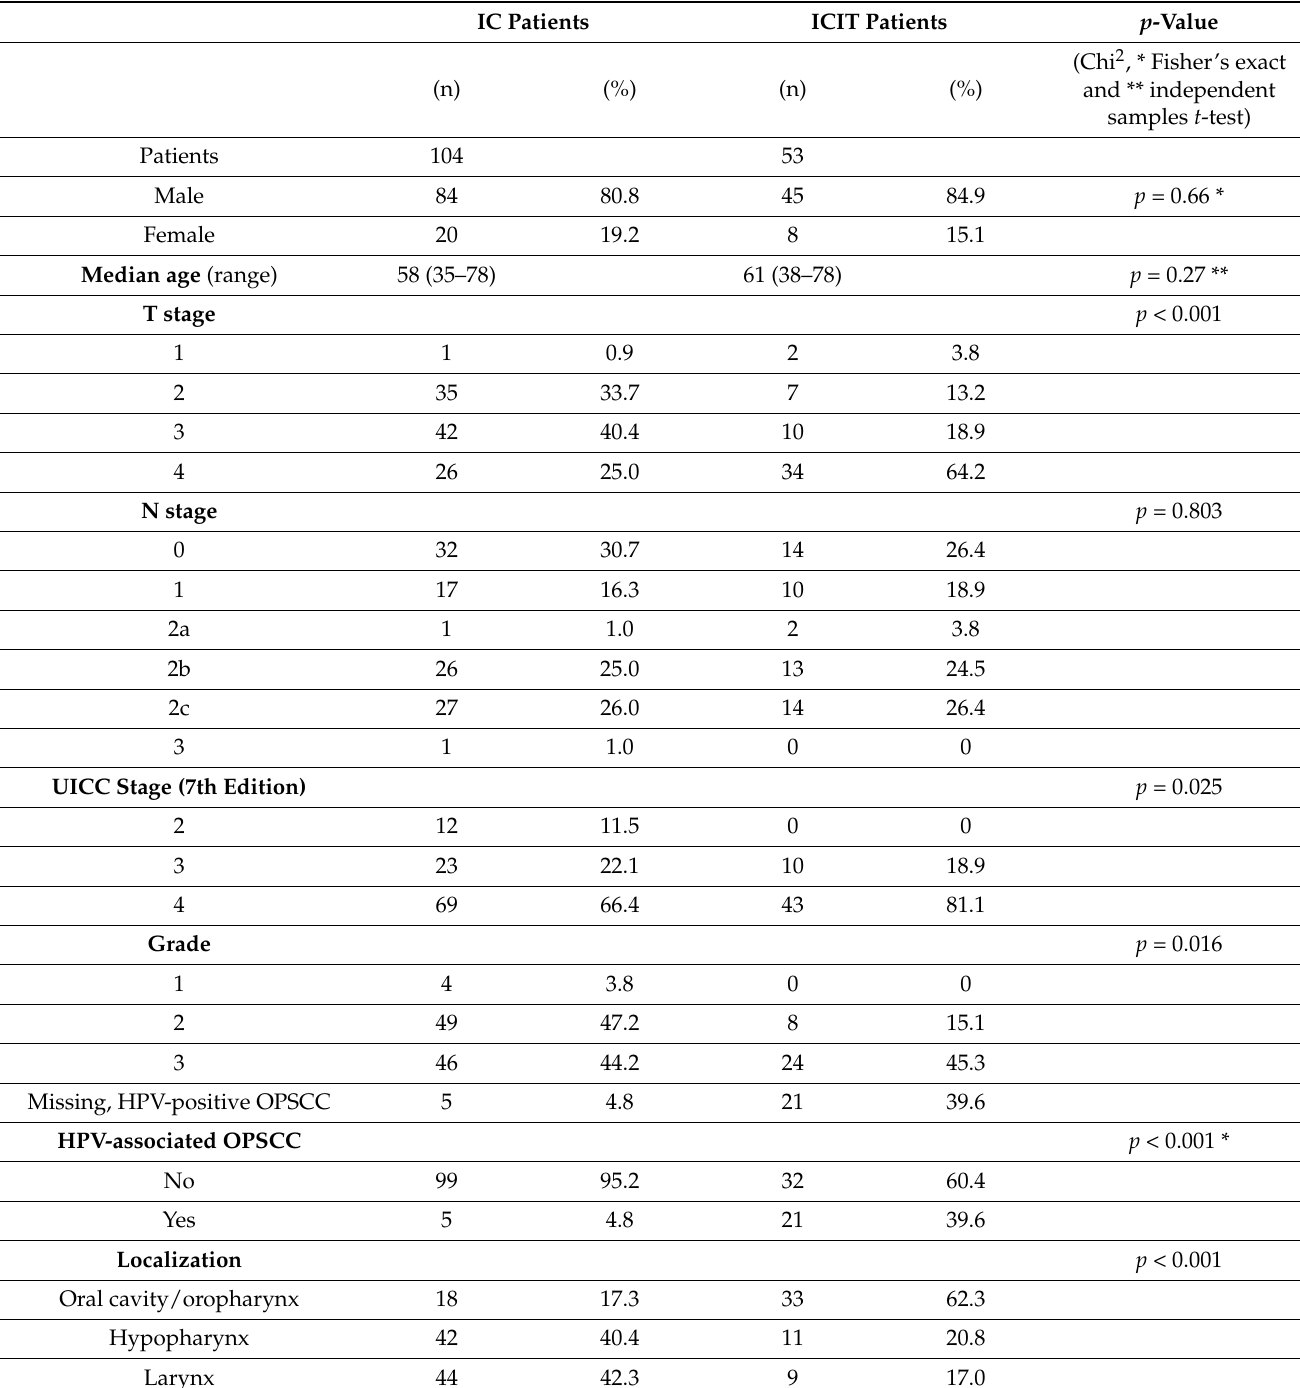
Table 1. Patient